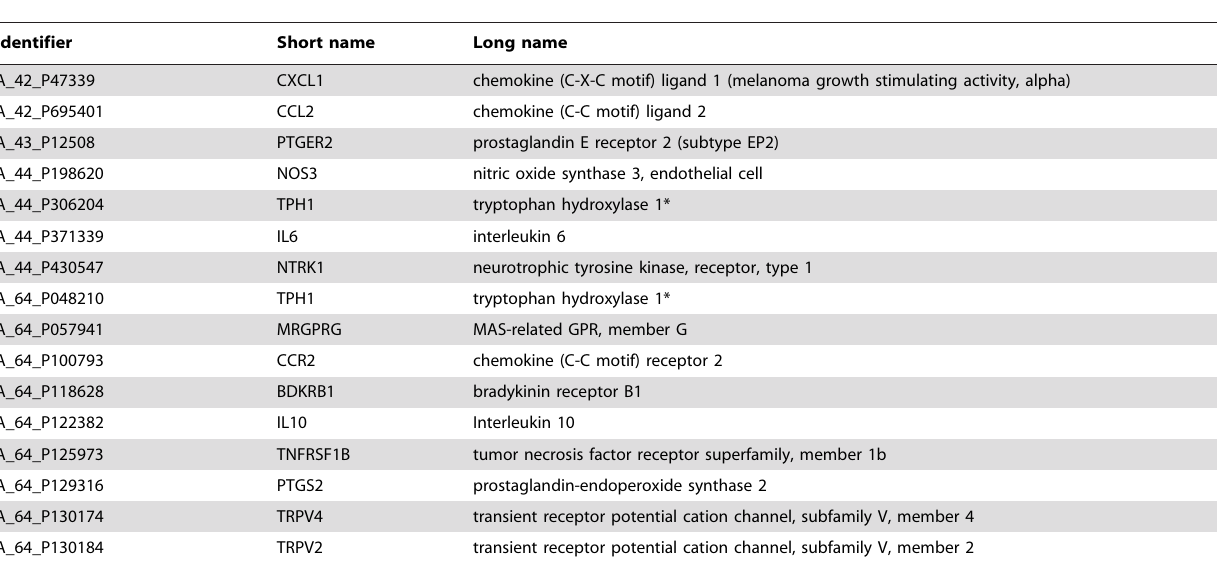
Table 4. Upregulated genes specifically involved in pain transmission in NMS rats in comparison with normal animals.